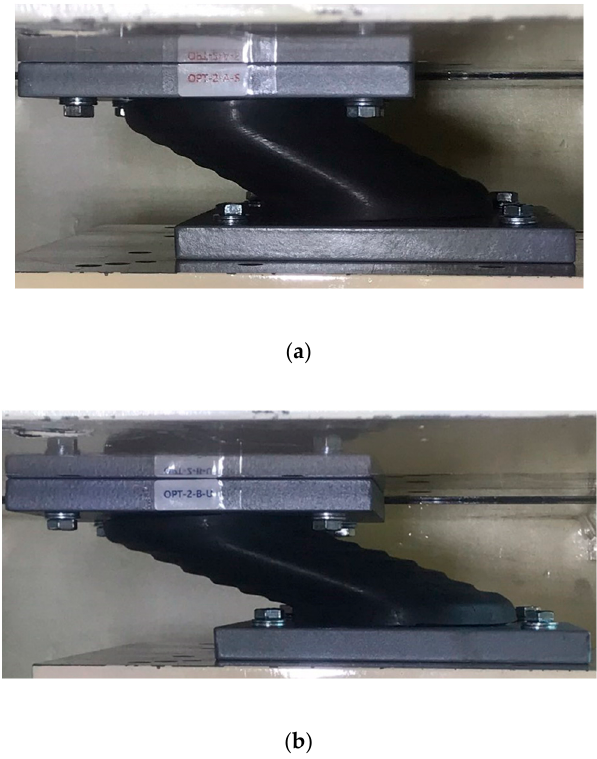
Figure 20. Photos of shear deformation for OPT-2: ( a ) 400%; ( b ) 600%.